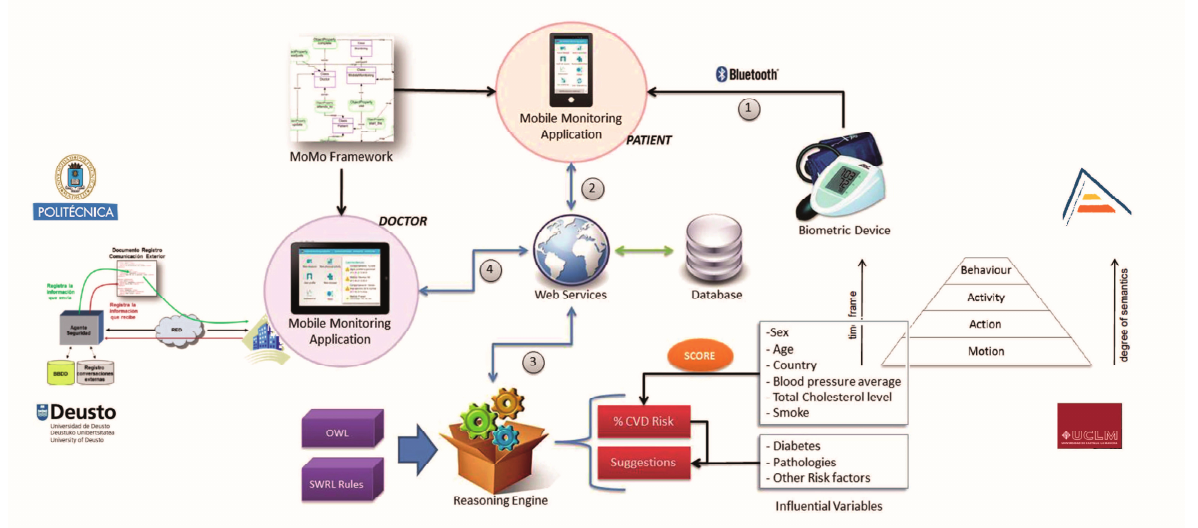
Figure 1. TALISMAN+ Integration of heterogeneous sensors and reasoning